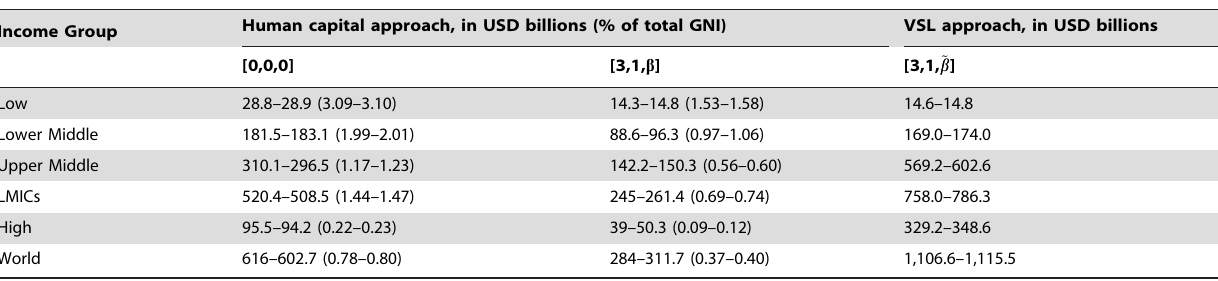
Table 3. Economic benefit of reducing injury